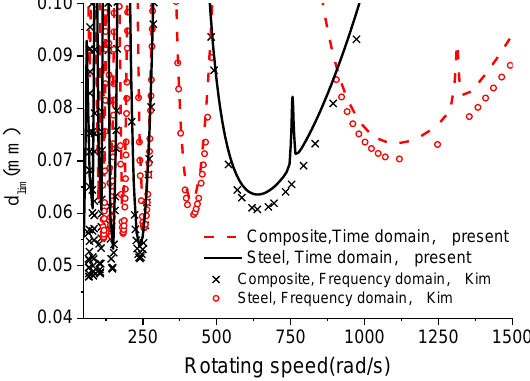
ff ects of material on Figure 6. The effects of material on stability. Figure 6. The e